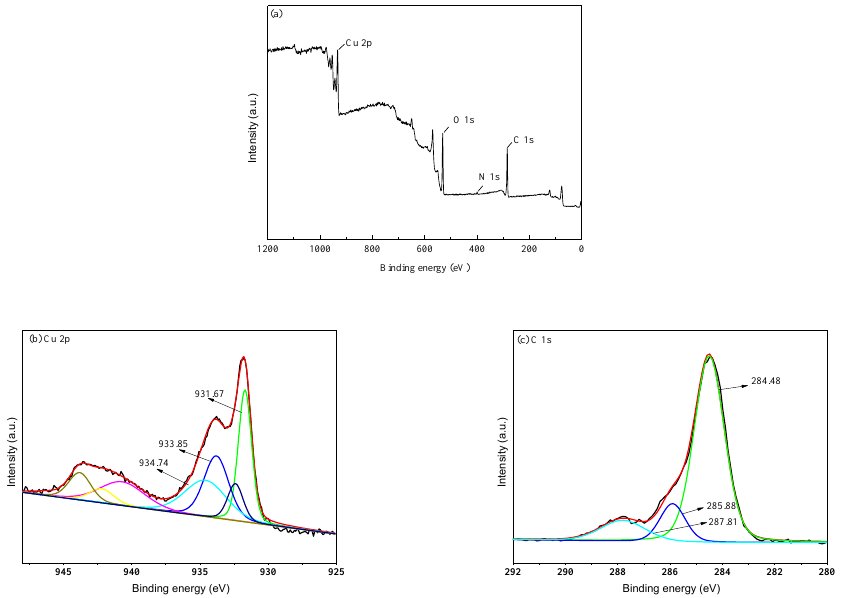
Figure 4. High-resolution XPS spectra of ( a ) CP@Cu after metal adsorption; ( b ) high-resolution Cu 2p spectra; ( c ) high-resolution C 1s spectra after adsorption.